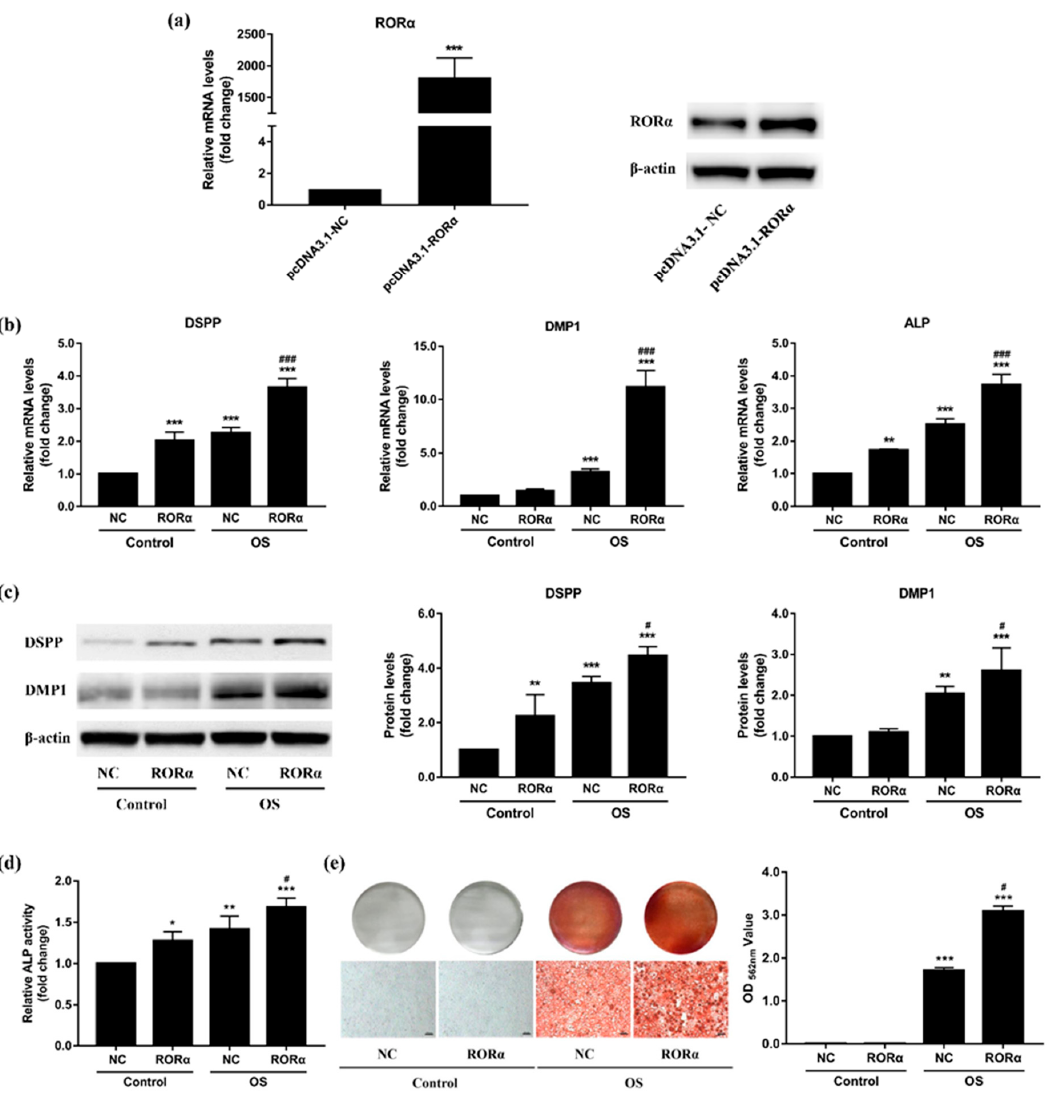
Figure 4. Effect of retinoid acid receptor-related orphan receptor α (ROR α ) overexpression on odontoblastic differentiation of rat dental papilla cells (rDPCs). rDPCs were transfected with pcDNA3.1-ROR α (ROR α group) or pcDNA3.1-NC (negative control group) for 24 h and then cultured in control or odontogenic induction (OS) medium for 3 or 7 days. ( a ) The transfection efficiency of ROR α overexpression was assessed by quantitative reverse transcription polymerase chain reaction (qRT-PCR) and western blotting. ( b ) The mRNA levels of dentin sialophosphoprotein (DSPP), dentin matrix protein 1 (DMP1), and alkaline phosphatase (ALP) were detected by qRT-PCR after 3-day induction. Glyceraldehyde-3-phosphate dehydrogenase (GAPDH) was used as the normalisation control; ( c ) The protein levels of DSPP and DMP1 were measured by western blotting after 7-day induction. β -actin was used as the internal control; ( d ) ALP activity in cellular lysates was determined after 7-day odontogenic induction. ( e ) The formation of mineralized nodules was visualized by alizarin red staining at 7 days after induction. Scale bar: 100 μ m. All data are presented as the mean ± SD ( n = 3). * p < 0.05, ** p < 0.01, *** p < 0.001 vs. pcDNA3.1-NC or Control-NC group, # p < 0.05, ### p < 0.001 vs. OS-NC group.